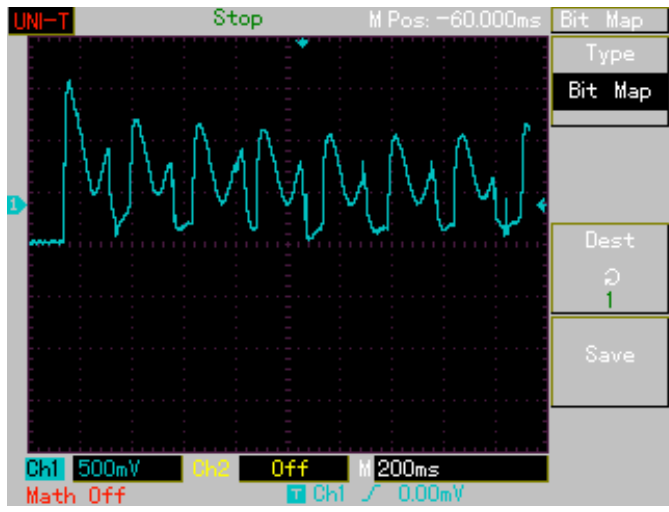
Figure 19. Time variation of the motor